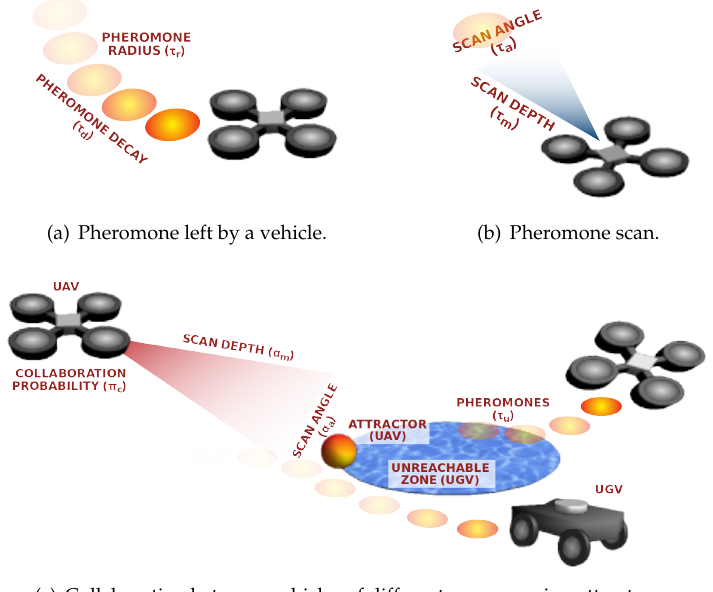
Figure 3. Parameters of ABISS. The UAV has to decide whether to go to explore the water surface where the UGV has left an attractor because it could not